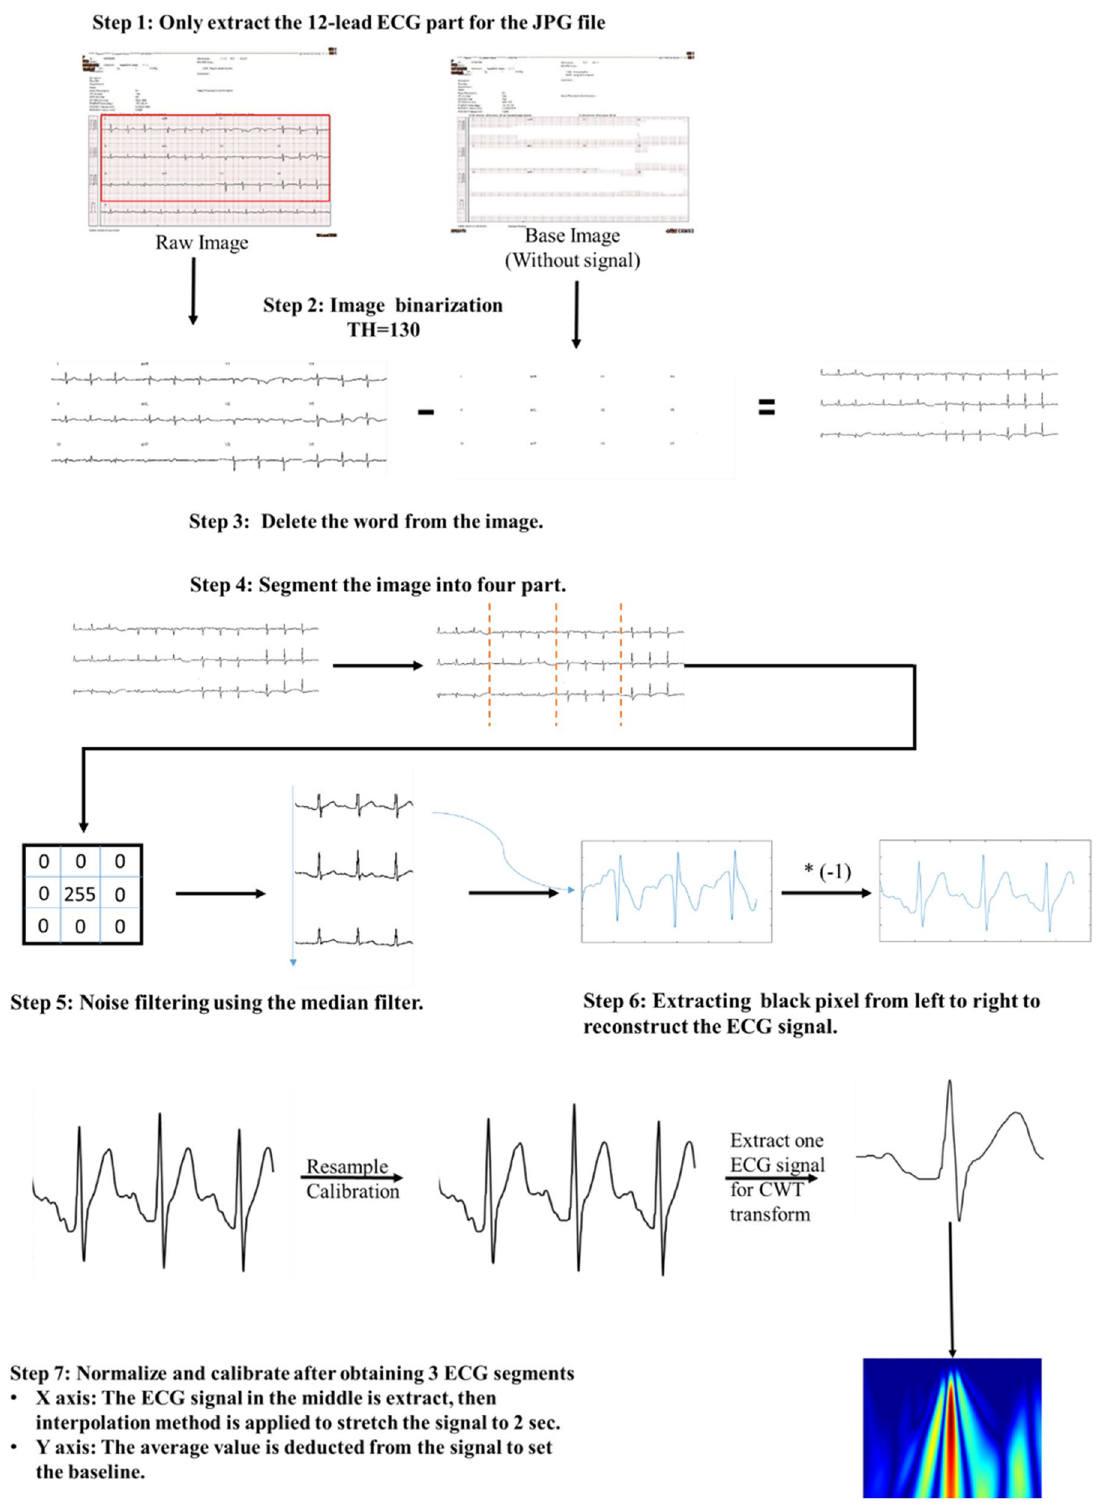
Figure 4. 12-lead ECG signal preprocessing. Details are provided in seven steps. Before converting the 12-lead ECG images into the signal, it was necessary to confirm the target area of the ECG signal and then crop the region containing the ECG image and transform the RGB image into a grayscale image. Image binarization could convert the color of the signal and background into black or white. Then, the pixel bits of each lead signal were regarded as coordinates: X, regarded as time, and Y, regarded as relative size, were independently accessed. The squares on the 12-lead ECG images were used as the basis for determining the length of time required to reconstruct the original signal. Finally, the interpolated signal was used to compare the relative position of the pixel to the time required to reconstruct the electrical signal and the signal’s